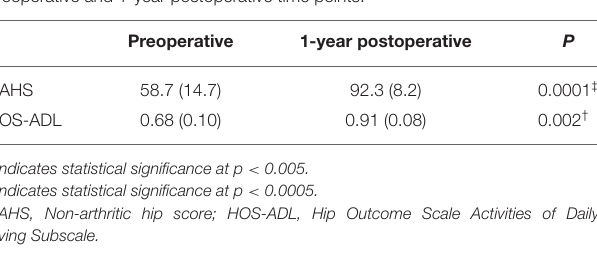
TABLE 2 | Patient reported outcome scores for the FAIS group at the preoperative and 1-year postoperative time